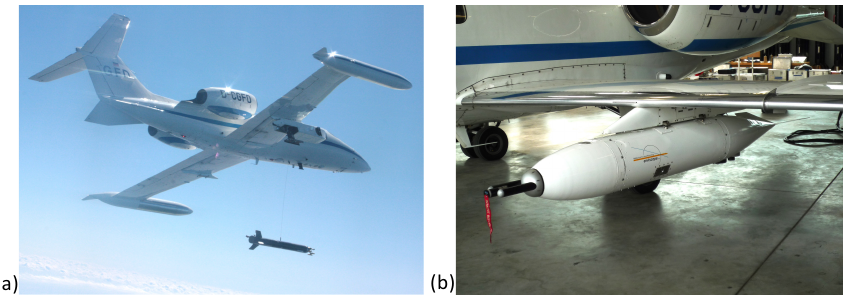
Figure 1. (a) Advanced AIRTOSS–Learjet tandem platform: Learjet 35A with the sensor shuttle (called AIRTOSS) during a test flight. The photograph was taken during the release of AIRTOSS. When AIRTOSS is fully released, the distance between the Learjet and AIRTOSS is 3000ft (914m). (b) Attached sensor pod under the left wing of the Learjet with the mounted FSSP at the tip.